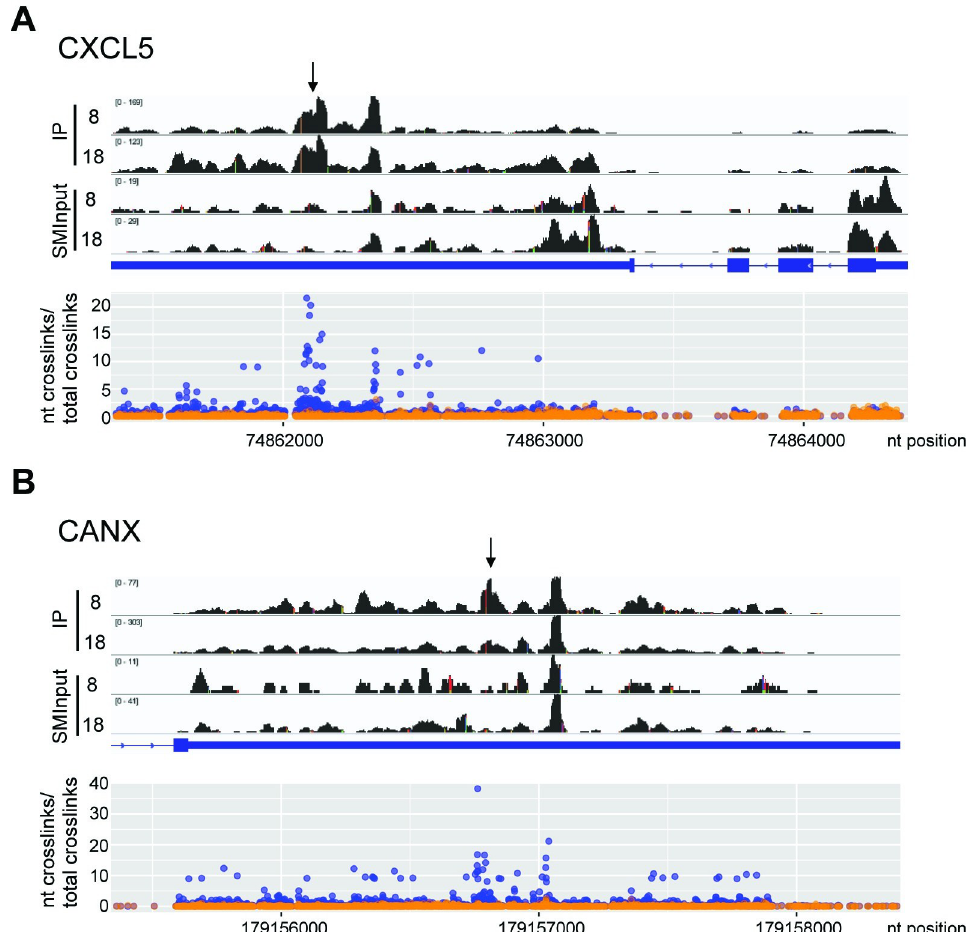
Fig 9. M2-1 binds specific regions of CXCL5 and CANX mRNAs. (A) The upper panel shows read coverage tracks of the CXCL5 gene in M2-1 IP samples. A representative 8 and 18 hpi replicate is presented. Note that the y -axes are scaled differently for each track to allow direct comparison. The gene organization is shown below, with exons shown as thick blue lines, the untranslated regions as a medium blue line and introns as thin blue lines. Arrowheads on the blue lines represent the gene orientation. The lower panel shows the number of nucleotide crosslinks per genomic position within CXCL5 for SMInput samples (orange) and IP samples (blue). The mean averages of all 5 replicates are represented. (B) Same as A, but for the relevant portion of the CANX gene (the remainder of the gene was omitted due to its large size). Black arrows represent the CLIPper identified peak that was common to all five